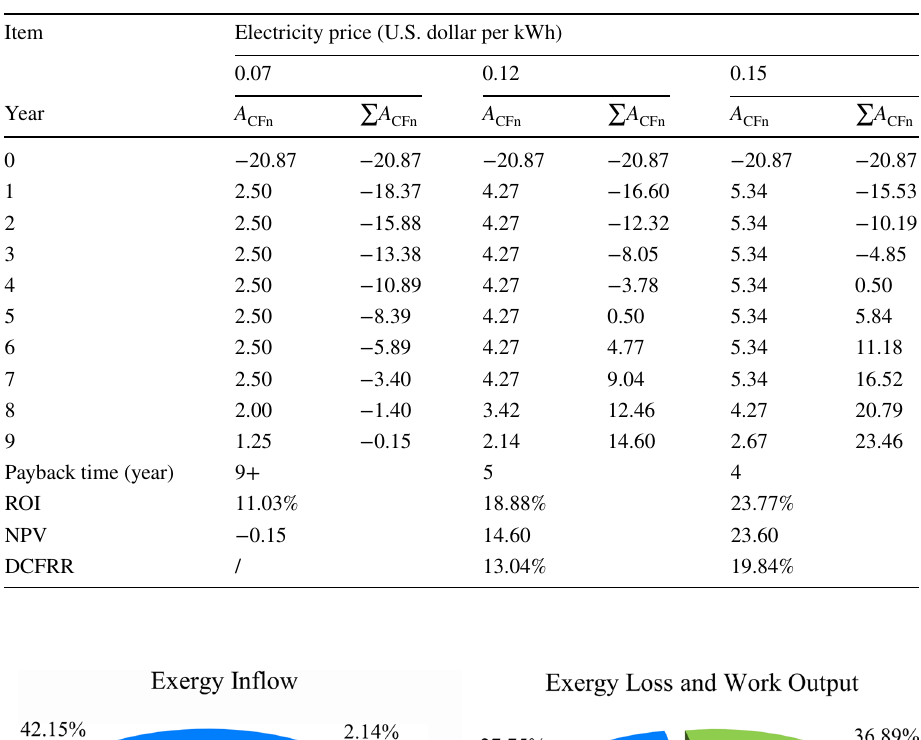
Fig. 5 Distribution of exergy input, exergy loss and electrical power